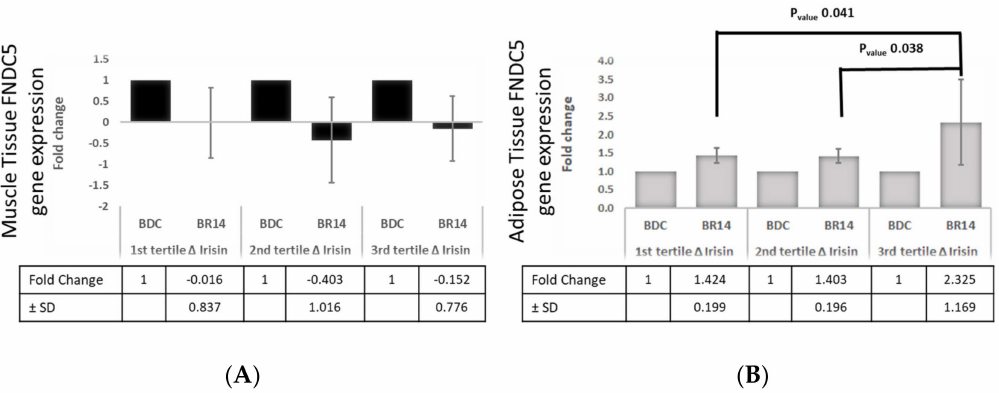
Figure 4. Effect of 14-day Bed Rest on the change of FNDC5 gene expression in muscle ( A ) and adipose tissue ( B ). BDC, baseline data collection; BR14, after 14-day Bed Rest data